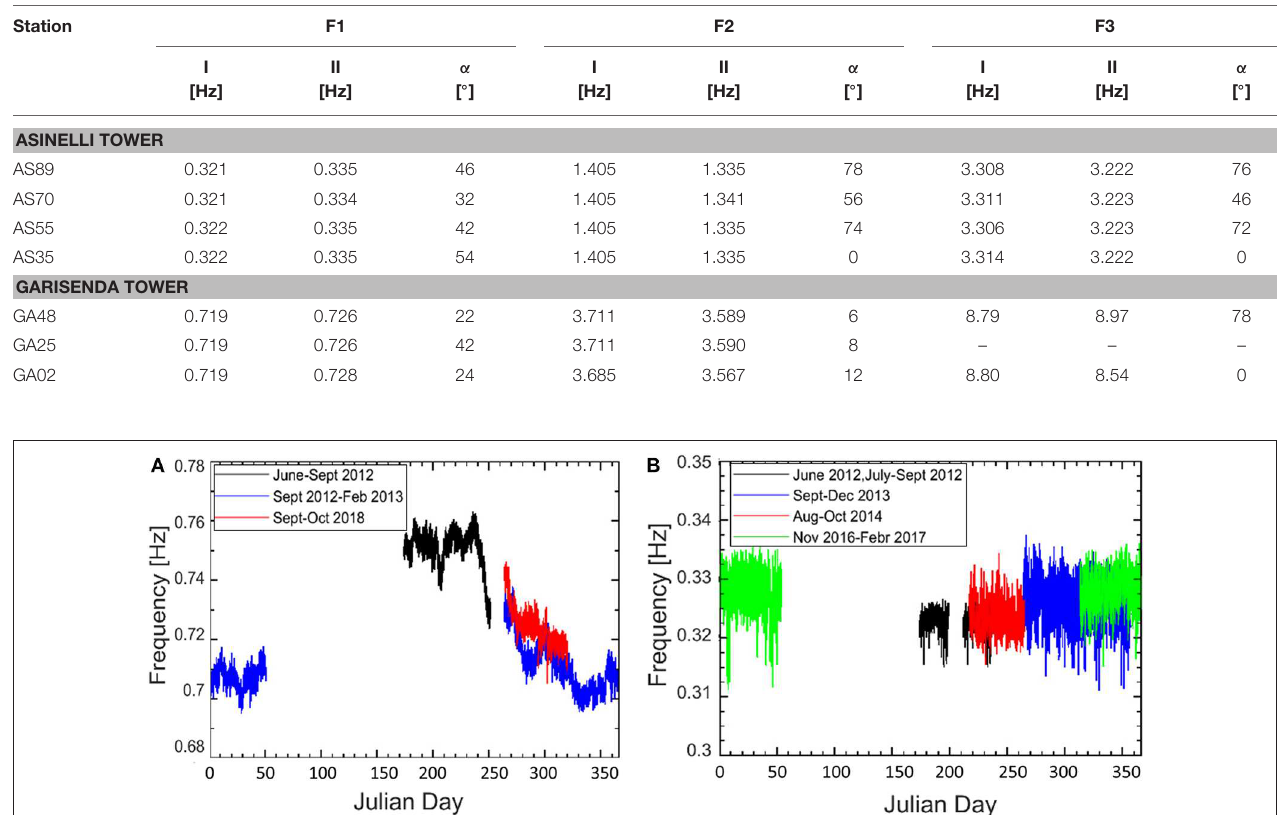
TABLE 1 | Angle of principal directions α (measured clockwise from North) and measured frequencies along EW and NS directions, for the three fundamental flexural modes of all the stations installed in 2013 inside the Asinelli and Garisenda Towers. Station